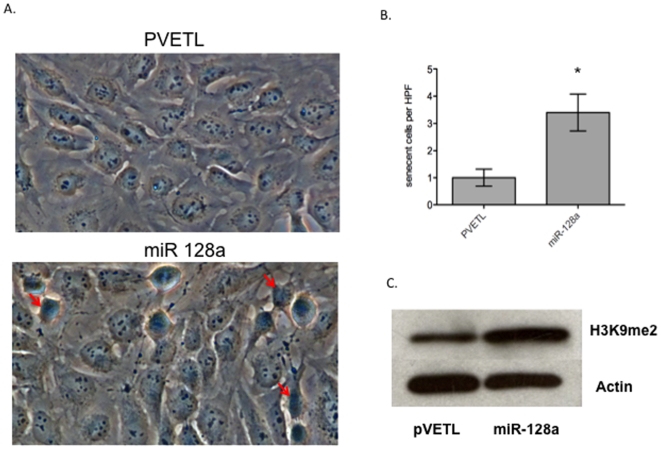
MiR-128a promotes senescence in medulloblastoma cells.A) MiR-128a induces senescence in medulloblastoma cells as detected by SA-beta galactosidase staining (dark blue cells; examples indicated by red arrows). B) Cell counts per High Powered Field of β-gal positive cells in control vector (pVETL) or miR-128a transfected cells, *p = 0.003. C) Western blot analysis showing increased level of H3K9me2 protein in Daoy cells transfected with miR-128a when compared to the empty vector. Actin is used as an internal control.